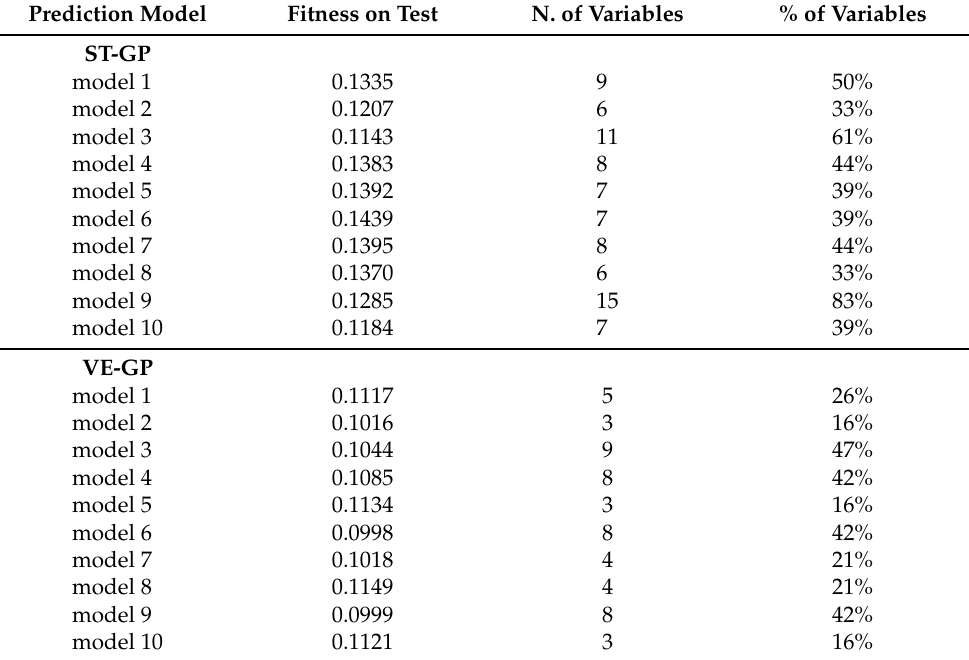
Table 8. Fitness on the test set, number of involved variables, and corresponding percentage for each model evolved by ST-GP (upper table) and VE-GP (lower table) in each of the 10 runs. Prediction Model Fitness on Test N. of Variables % of Variables